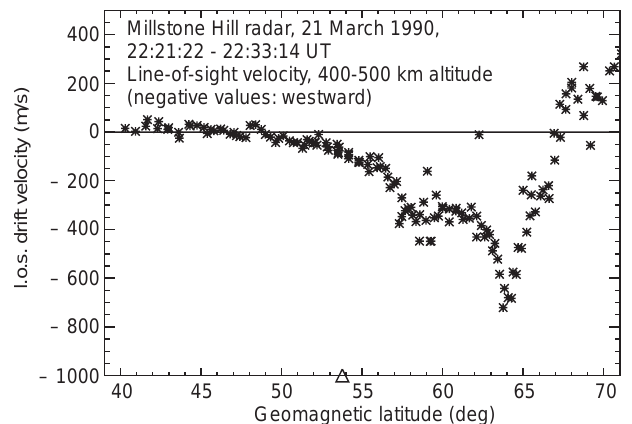
Fig. 10. Line-of-sight drift velocity in the 400–500 km altitude range as measured by the Millstone Hill radar with the azimuth-elevation scan during the passage of the Active satellite, orbit 2174